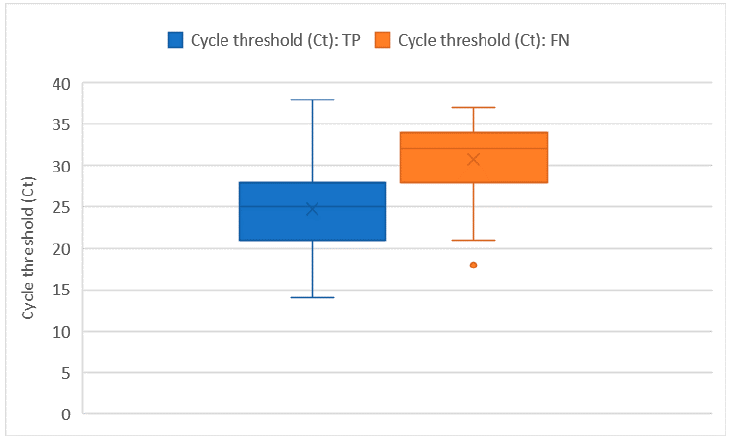
Figure 3. Ct distribution among true positive (TP) and false negative (FN) tests. Figure 4 represents how LumiraDx™ sensitivity changes by the variation of both Ct values and Days.